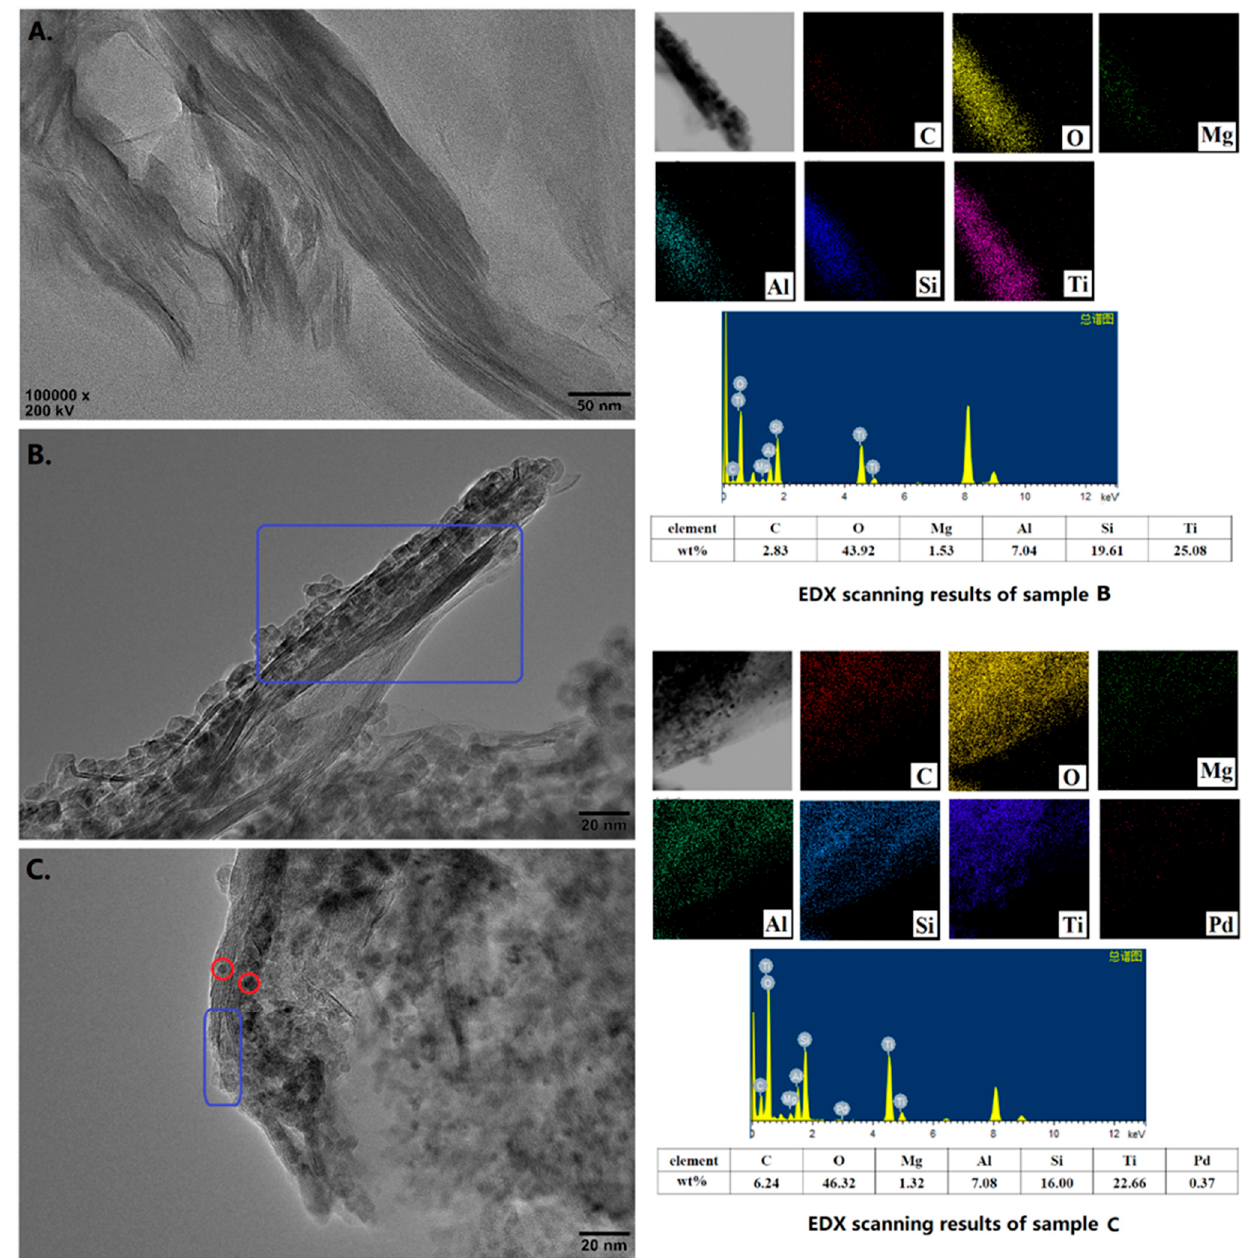
Figure 7. HRTEM images and element mapping results of the starting MMT ( A ), TiO 2 -MMT 60 /PCN 40 ( B ), and TiO 2 -MMT 60 /PCN 40 @Pd 0 nanocomposite ( C ). ( B ), and TiO 2 -MMT 60 /PCN 40 @Pd 0 nanocomposite ( C